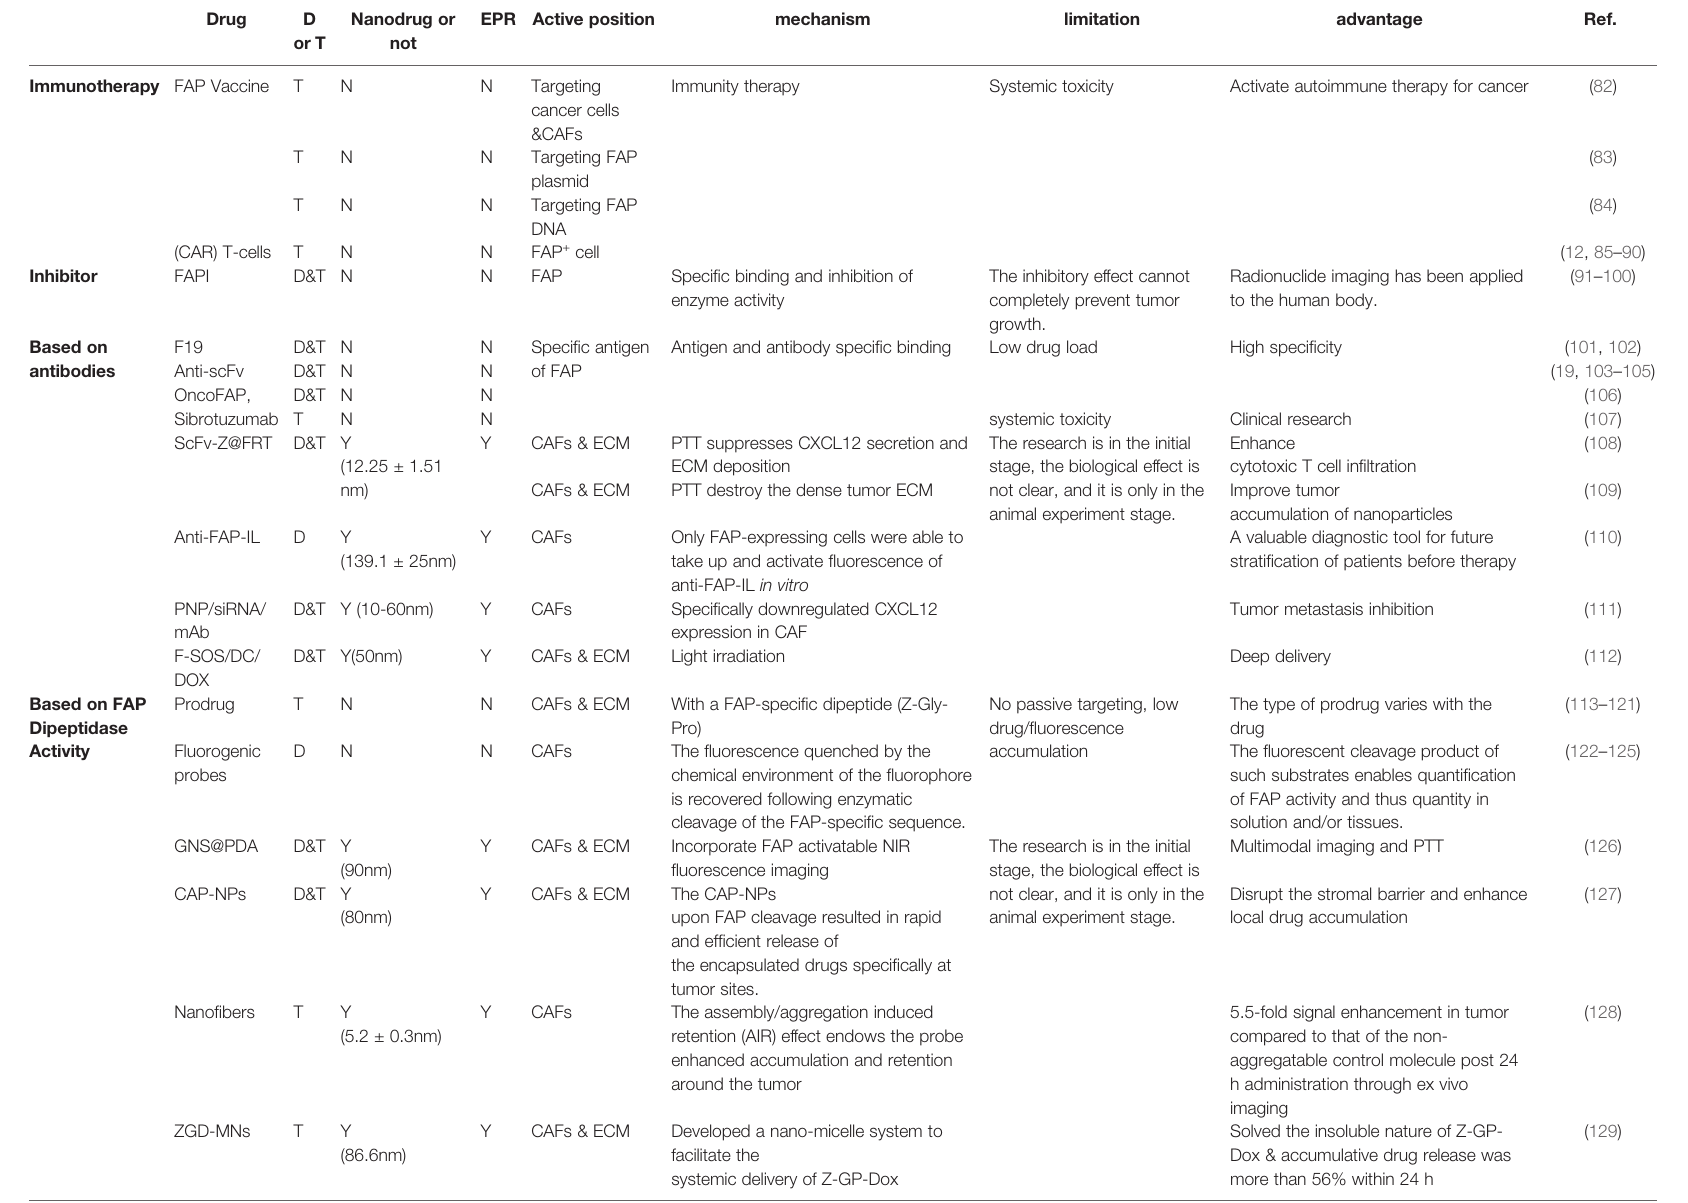
TABLE 2 | Summary of targeting FAP